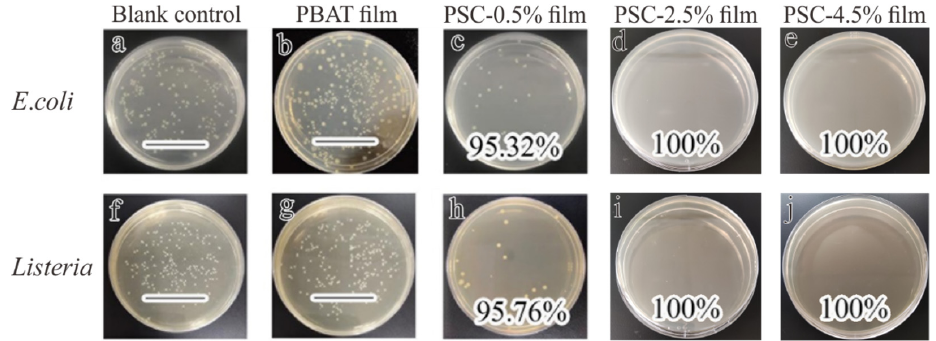
Figure 10. Image ( a – e ) are the E. coli antibacterial results of films; image ( f – j ) are Listeria monocytogenes antibacterial results of films (“–” means no zone of inhibition).